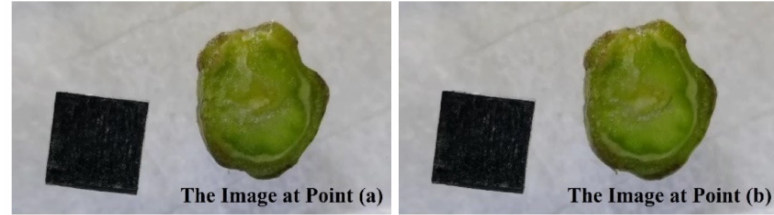
Figure 4. Images of the stem specimen at point ( a ) and point ( b